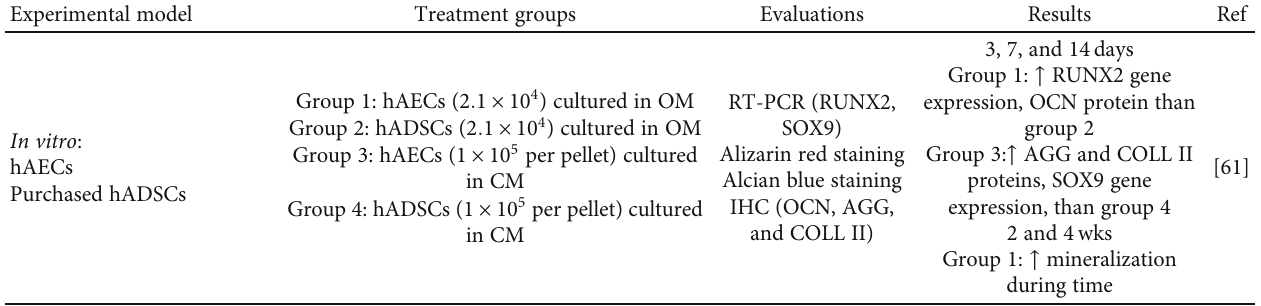
Table 4: In vitro , in vivo , and clinical studies on AECs in bone